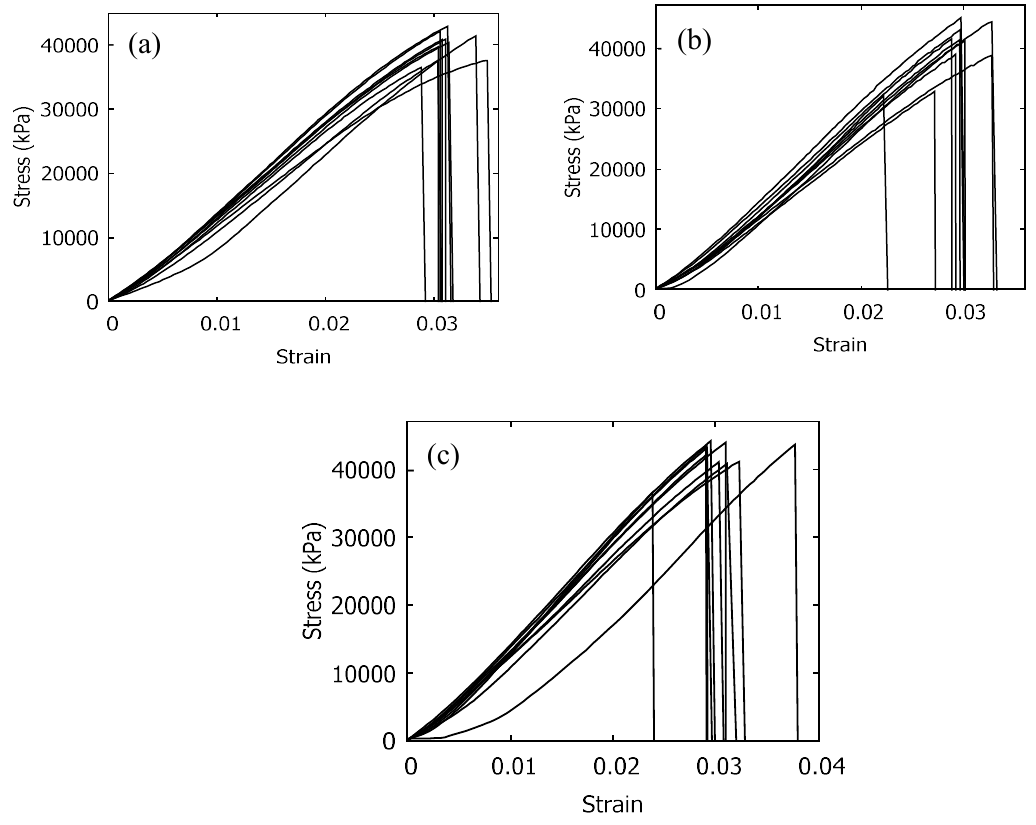
Figure 7. Stress–strain curves for 10 samples at different strain rates: ( a ) 0.00028 s −1 , ( b ) 0.00085 s −1 , and ( c ) 0.0017 s −1 for 300 µm filler-reinforced composites.